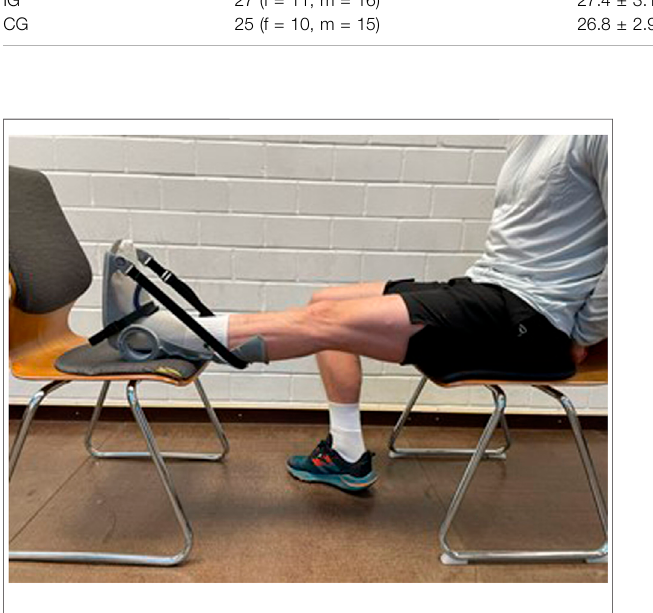
FIGURE 1 | Orthosis used for calf muscle stretching. FIGURE 2 | Testing device for maximal isometric strength in extended knee using leg press